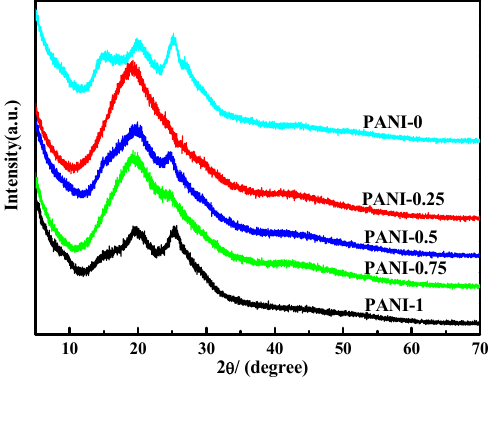
Figure 3. X-Ray Diffraction (XRD) spectra of PANI with different amounts of water.